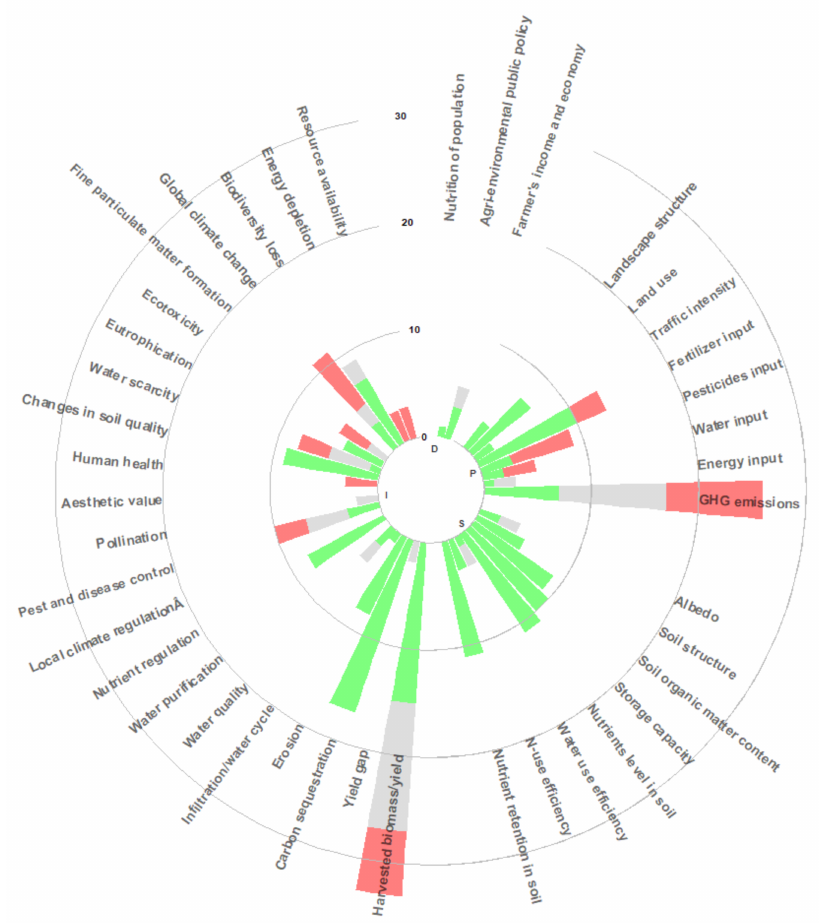
Figure 2. For each environmental sustainability indicator, the bar represents the number of papers showing a positive (green), a negative (red), or a variable effect (grey) on the environment. Indicators are sorted depending on the DPSIR framework (see